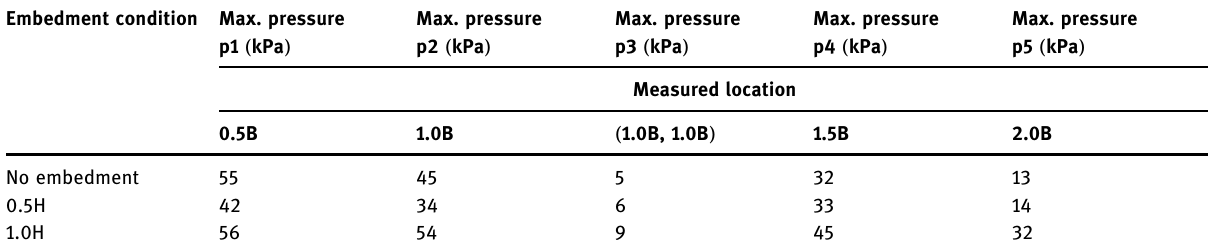
Embedment condition Max.